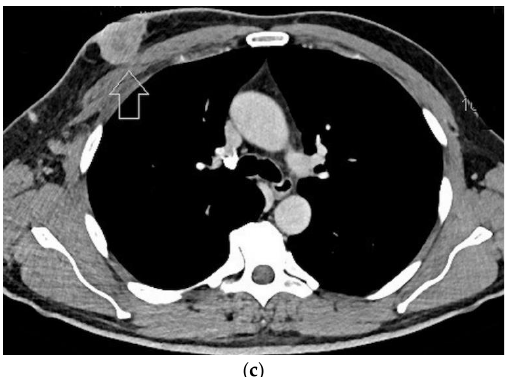
Figure 12. Locally advanced male breast cancer. Clinical picture ( a ), high-resolution sonography scan ( b ), and computed tomography scan in the portal phase of the breast lesion ( c ). The use of the high-frequency transducer allows the depiction of the tumor tissue infiltrating the nipple – areolar complex.